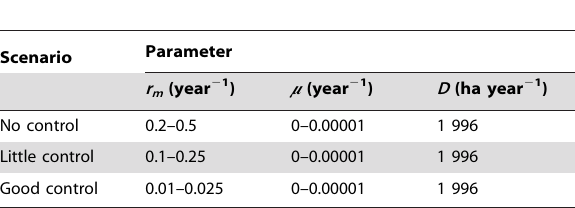
Table 2. Parameter values used in spread simulations using the spread model of Waage et al.